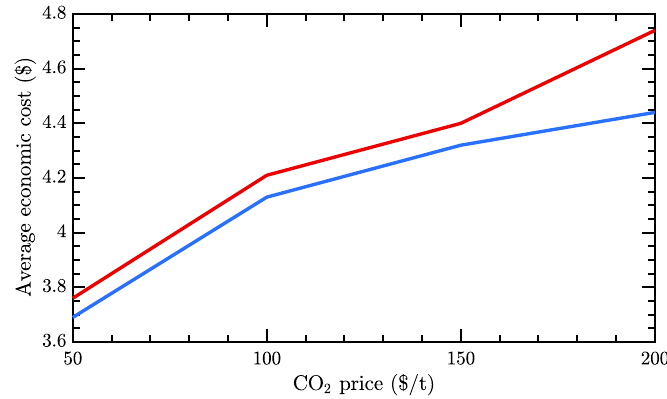
Figure 9. Average economic performance of the controllers under scenario 1 at different CO 2 prices. EMPC (blue), MPC